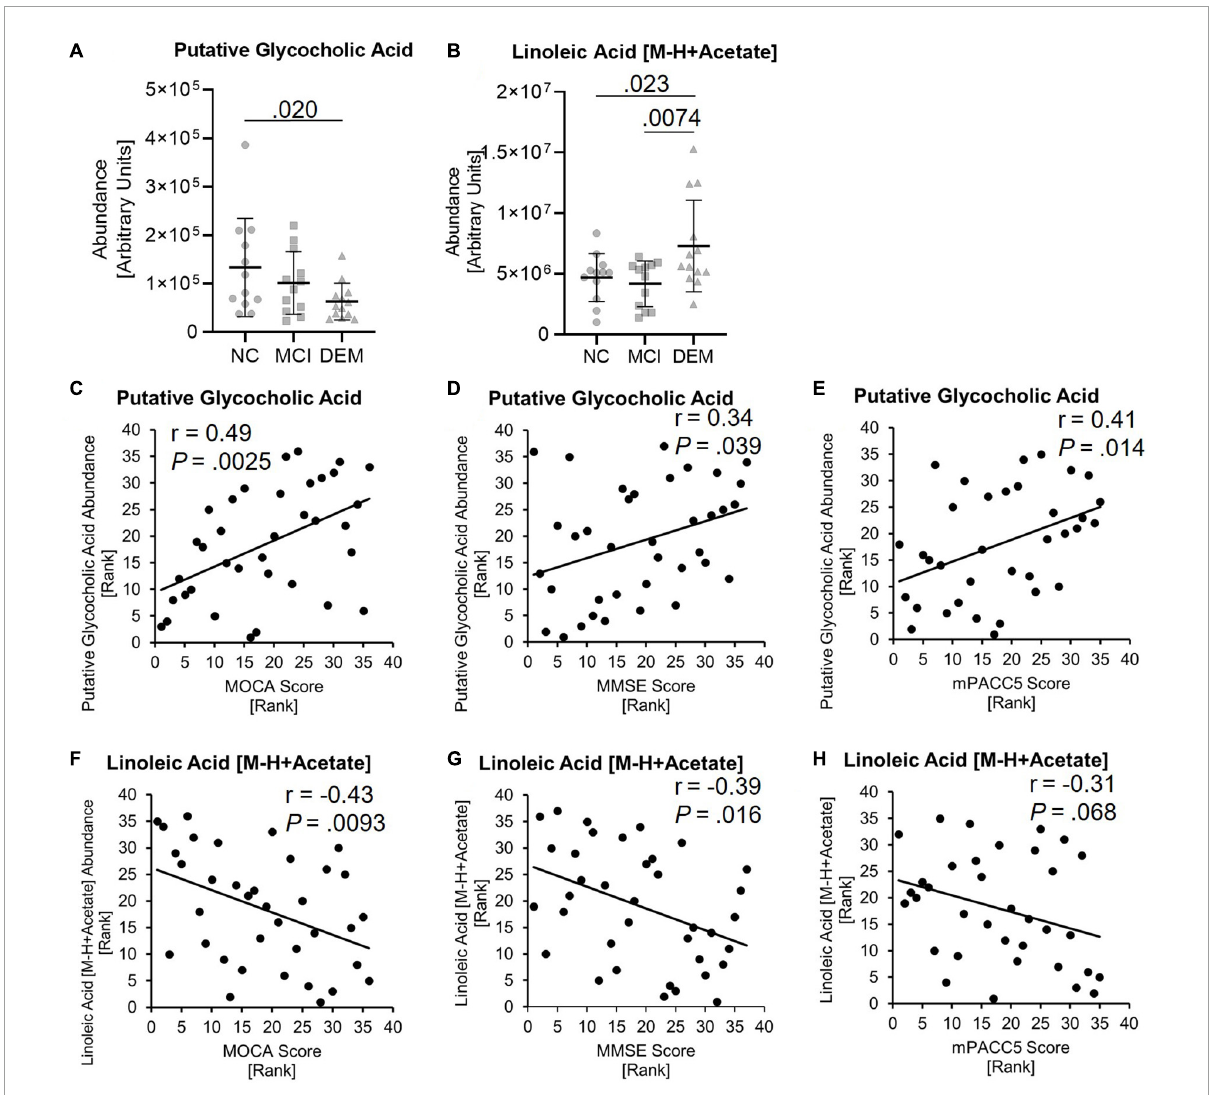
FIGURE4 Lipid candidates abundance differs between cognitive groups and correlate with cognitive scores. (A,B) Lipid abundance across cognitive groups. (C–H) Lipid candidates correlation with MOCA, MMSE, and MPACC5 cognitive scores. Exact P- values reported.